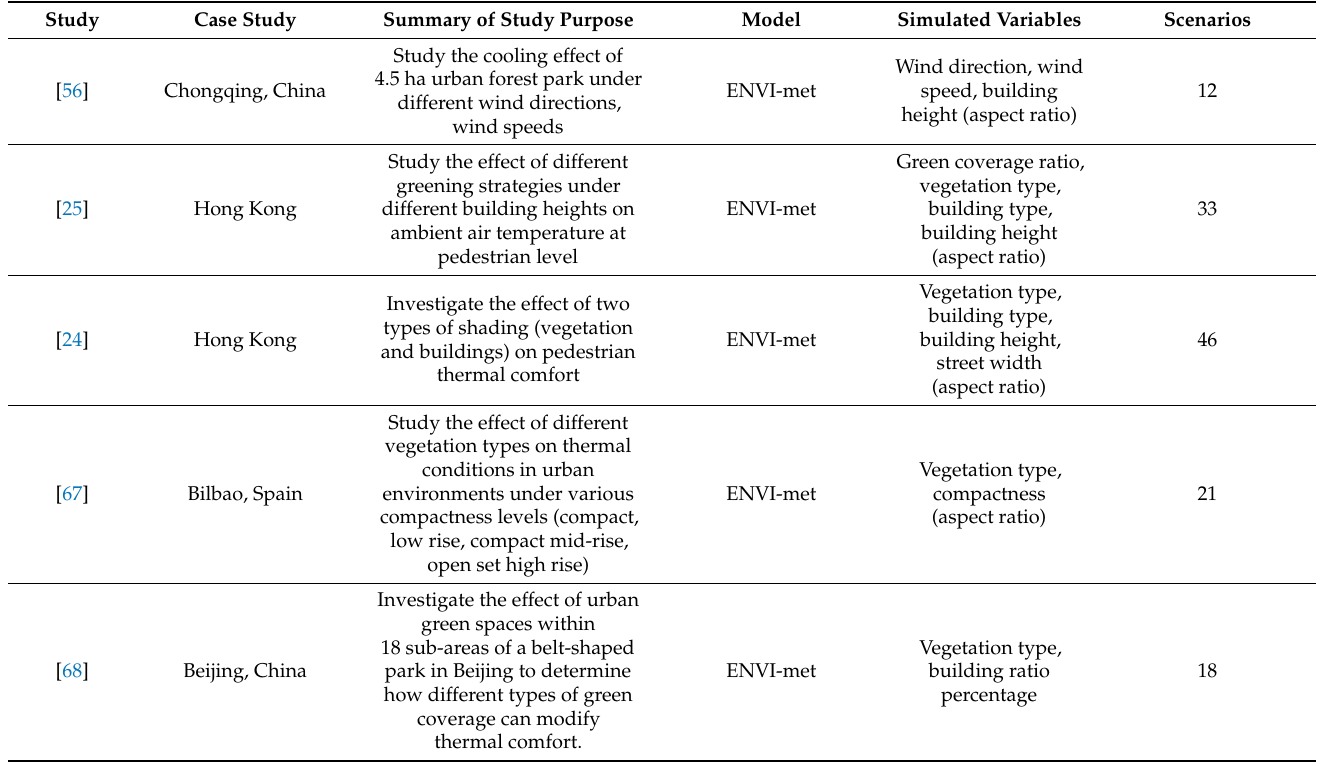
Table A1. Review of previous